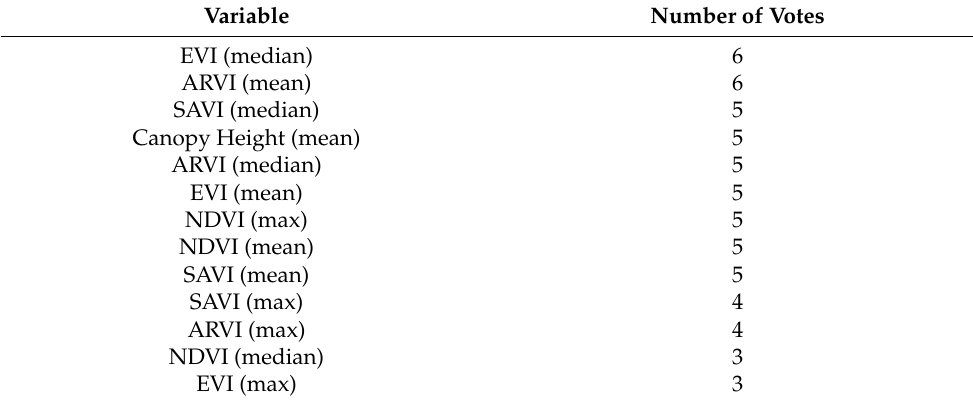
Table 4. Final variable selection after the Boruta method. Variables with more than three ‘keep’ votes from Boruta were added to the list and variables with more than three ‘reject’ votes were removed from the